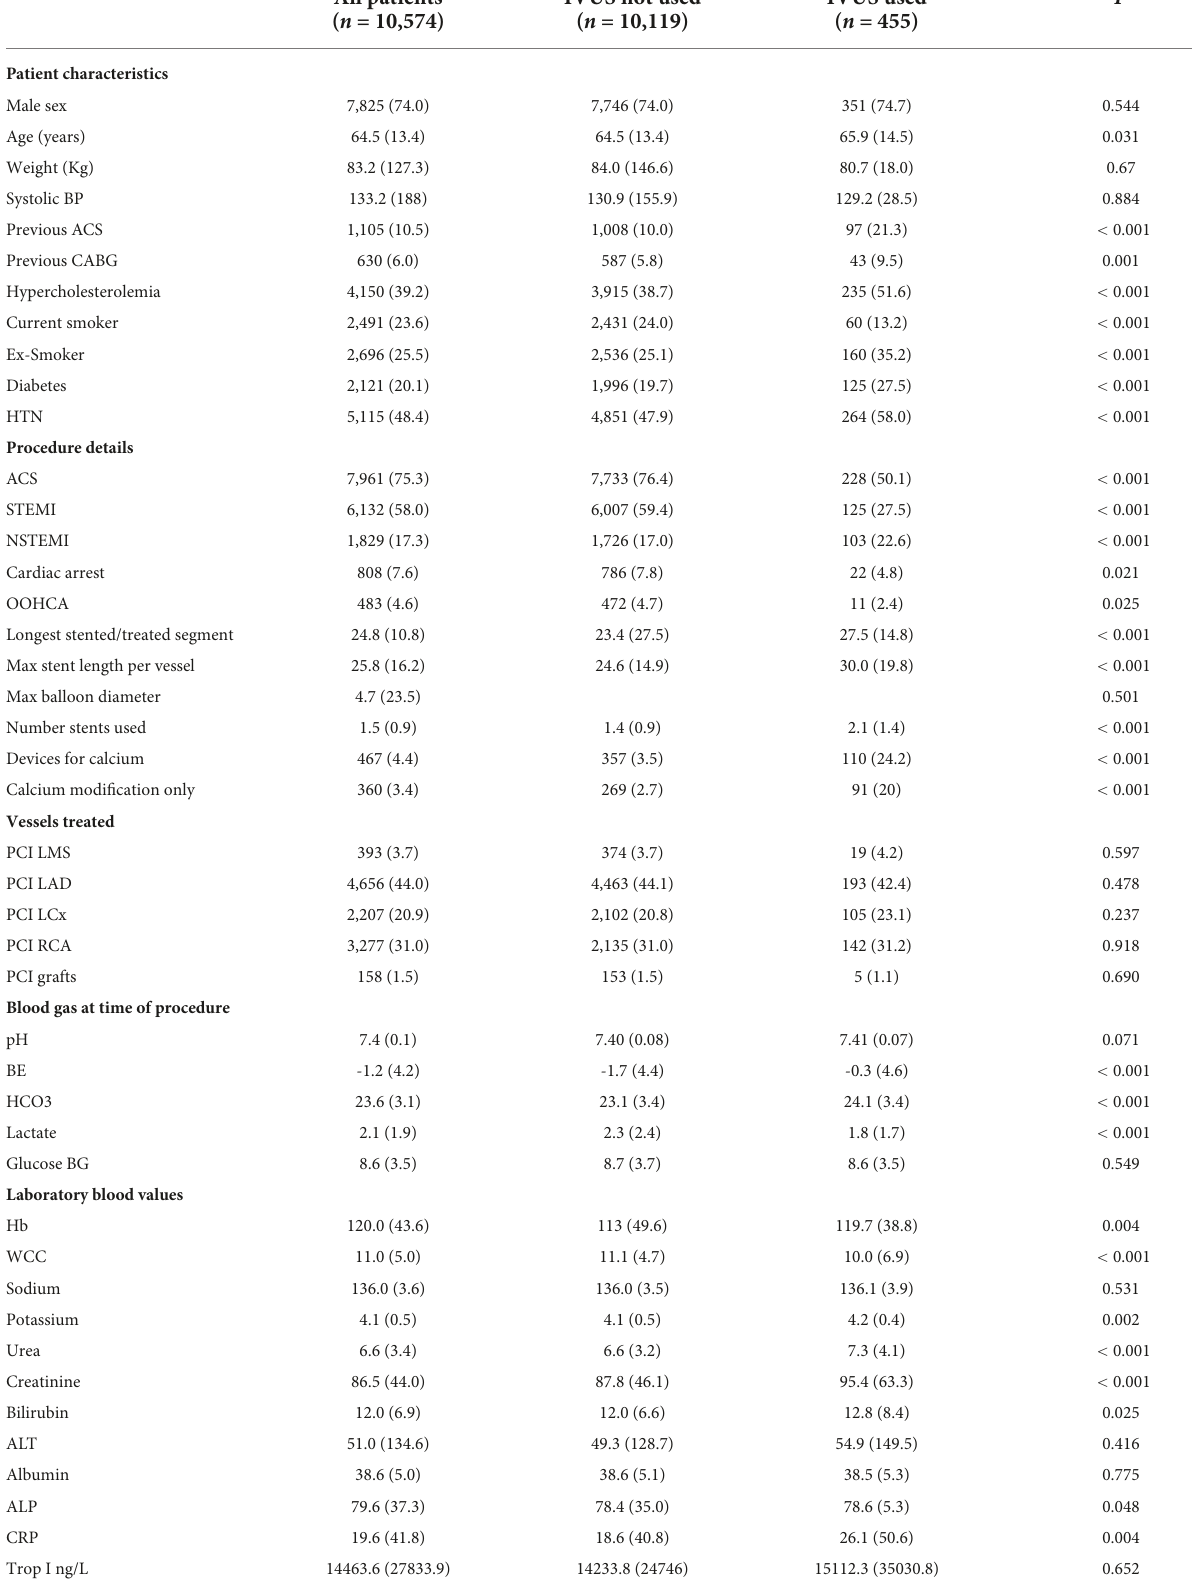
TABLE 1 Baseline characteristics and univariate analysis of patients undergoing index PCI